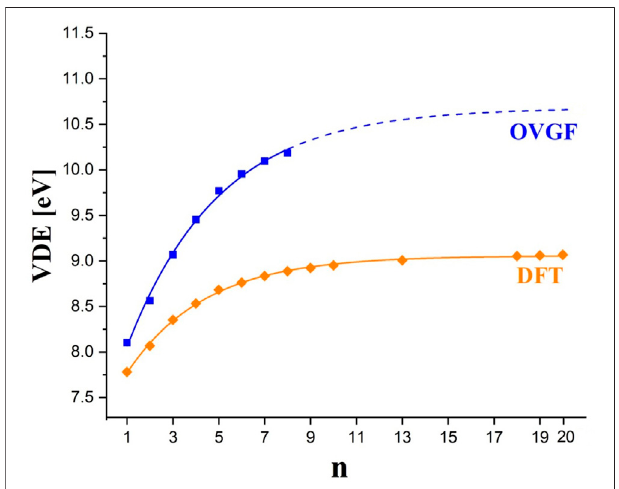
FIGURE 7 | The VDE OVGF values (blue squares) and VDE B3LYP values (orange diamonds) calculated for (BF 3 (BN) n F 4 n +1 ) – anions. The plots correspond to the fi tting formula given by VDE (cid:1) A · exp (− n / B ) + C (where A , B , and C stand for fi tting parameters). The fi tted parameters A = − 3.36783 ± 0.09853, B = 4.00503 ± 0.45838, and C = 10.68291 ± 0.14242 and the coef fi cient of determination r 2 = 0.99665 were obtained for the function approximating VDE OVGF results (blue line) while A = − 1.72646 ± 0.02308, B = 3.40804 ± 0.08137, and C = 9.03863 ± 0.00786 and the r 2 of 0.99878 were obtained for that approximating VDE B3LYP results (orange